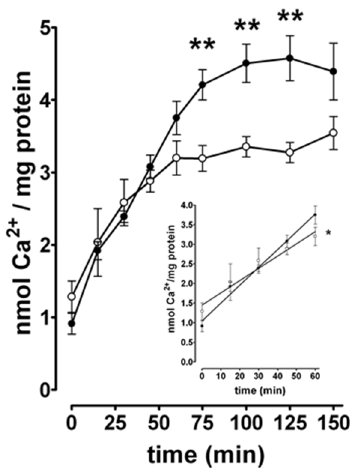
Figure 4. Low Mg 2+ -induced inhibition of total and initial rate of Ca 2+ uptake in hippocampal glial culture homogenates. Homogenates were isolated acutely from glial cultures incubated in either control (closed circles) or low Mg 2+ solution (open circles) for 3 h and standard Ca 2+ uptake reactions were performed as described under Materials and Methods. Two-tailed unpaired t -test was used to compare each time point of Ca 2+ uptake in control to low Mg 2+ homogenates (** p ≤ 0.004, 75, 100, and 125 min time points, n = 6 for both). Figure 4 (inset): Data points from 5 s to 60 min were subjected to linear regression analysis. Initial rates were determined from the slopes of the linear regression lines.